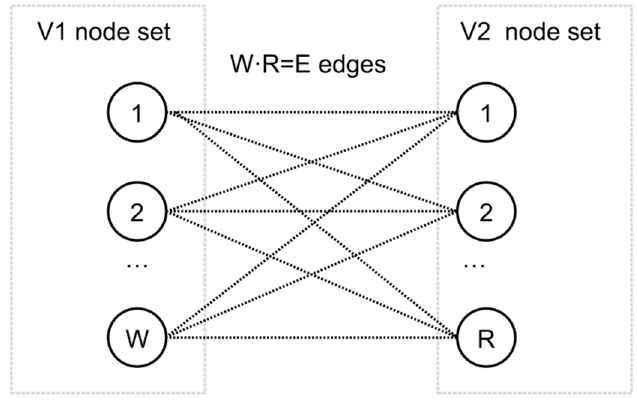
Figure 1. Generic representation of the posed matching